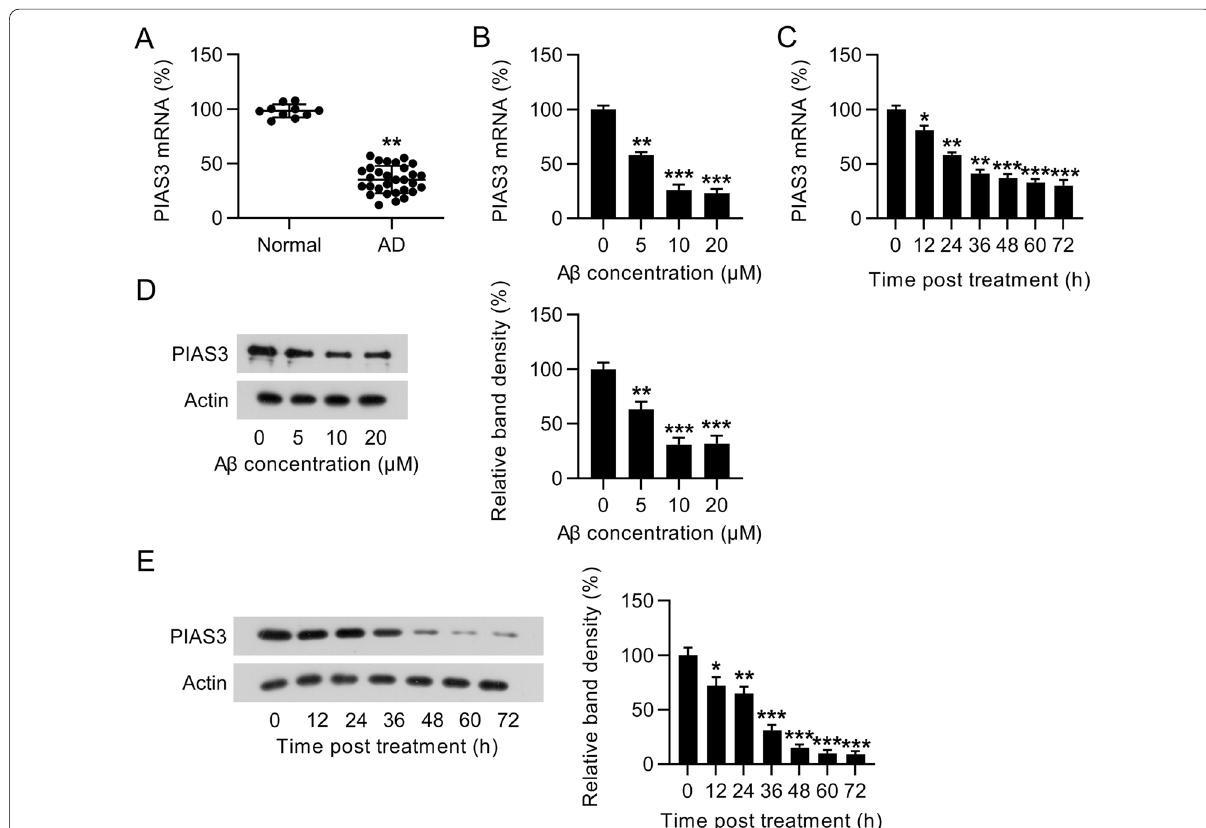
Fig. 1 PIAS3 expression in CSF tissues of patients with AD and AD model. A qPCR analysis revealed PIAS3 expression in CSF tissues of patients with AD (n 30) and normal participants (n 10). B – E SH-SY5Y cells were treated with Aβ (0, 5, 10, 20 μM in 0.1% DMSO) for 0, 12, 24, 36, 48, 60, = = and 72 h. qPCR and WB revealed the expression levels of PIAS3 in SH-SY5Y cells at the mRNA and protein levels. Data represent mean *p < 0.05, **p < 0.01, ***p < 0.001. PIAS3 protein inhibitor of activated STAT3, CSF cerebrospinal fluid, qPCR quantitative polymerase chain reaction,